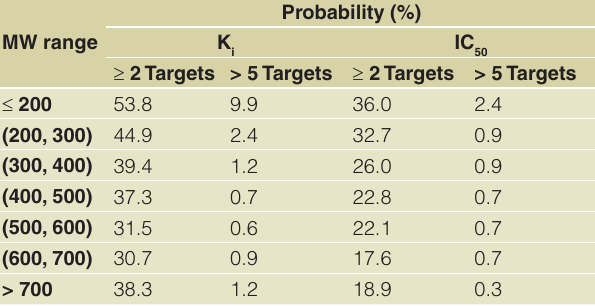
Table 5. Average promiscuity of compounds with different molecular weight.